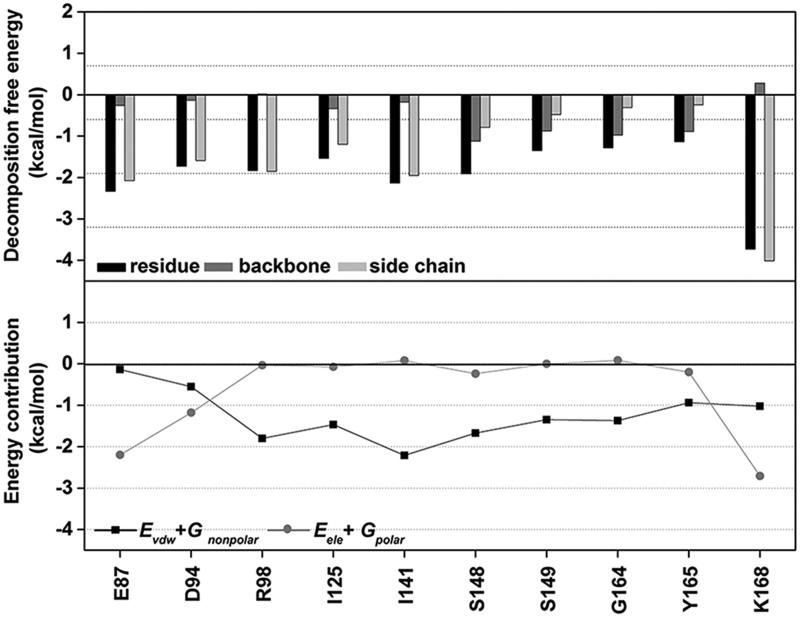
(Top) Per-residue decomposition free energy of the 10 key residues (black) and their contribution from backbone (dark gray) and side chain (light gray). (Bottom) The vdW (EvdW + Gnonpolar) and electrostatic (Eele + Gpolar) energy contributions are given in black and gray lines, respectively.